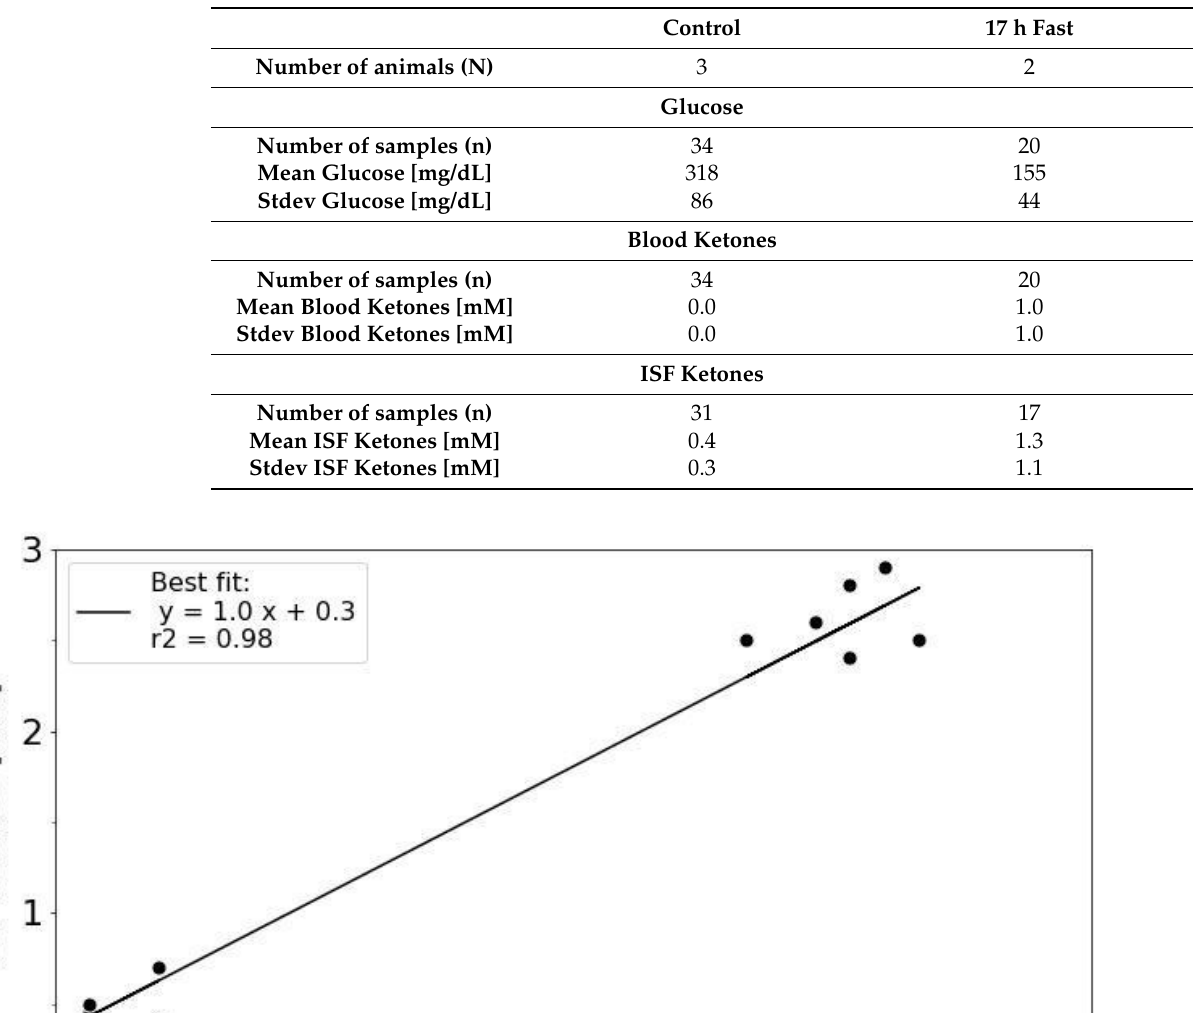
Table 1. Average glucose and ketone measurements for fasted versus non-fasted rats.